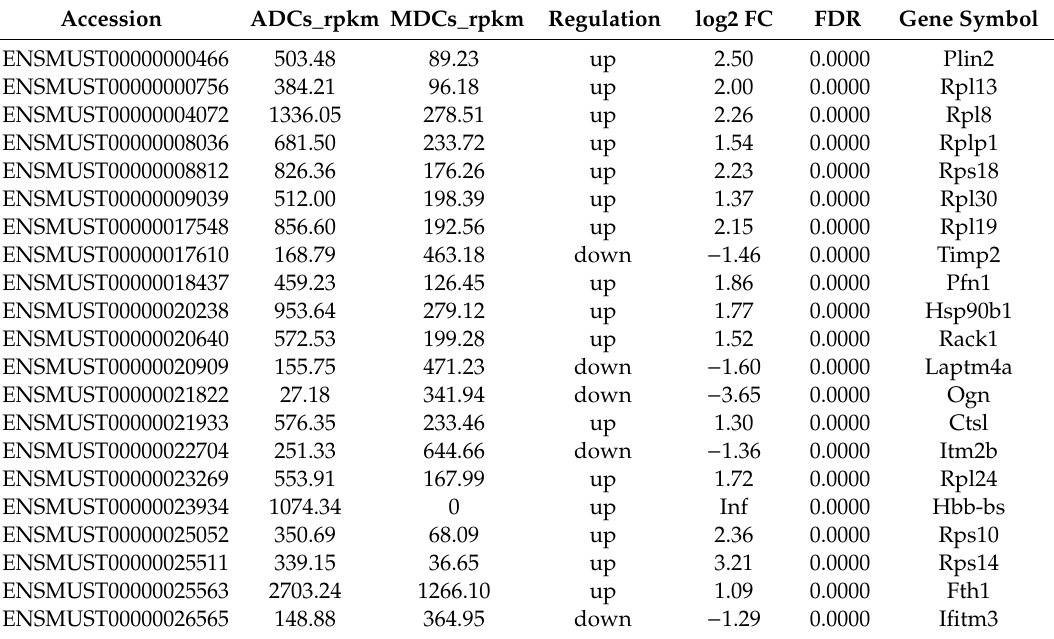
Figure 3. Di ff erentially expressed (DE) lncRNA transcripts in adipogenic di ff erentiated cells (ADCs) / myogenic di ff erentiated cells (MDCs). ( A ) Heatmap showing that ADCs exhibit a distinct lncRNA expression profile relative to MDCs and UDCs. Red indicates high expression levels, and green represents low expression levels. ( B ) Heatmap of DE lncRNAs in ADCs / MDCs. ( C ) Venn diagram of all expressed lncRNAs in ADCs / MDCs. ( D ) Volcano plot of the DE lncRNAs. Red indicates P ≤ 0.05. ( E ) Number of DE lncRNAs with P ≤ 0.05 and P ≤ 0.001. ( F ) Top 10 upregulated and top 10 downregulated lncRNAs in ADCs / MDCs. Table 2. The top 30 changed mRNA transcripts in ADCs vs. MDCs.